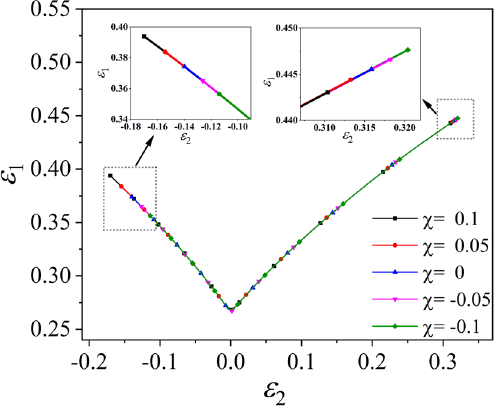
Figure 6. FLD of material TRIP780 based on Hill48 yield criterion and MMFC instability criterion.